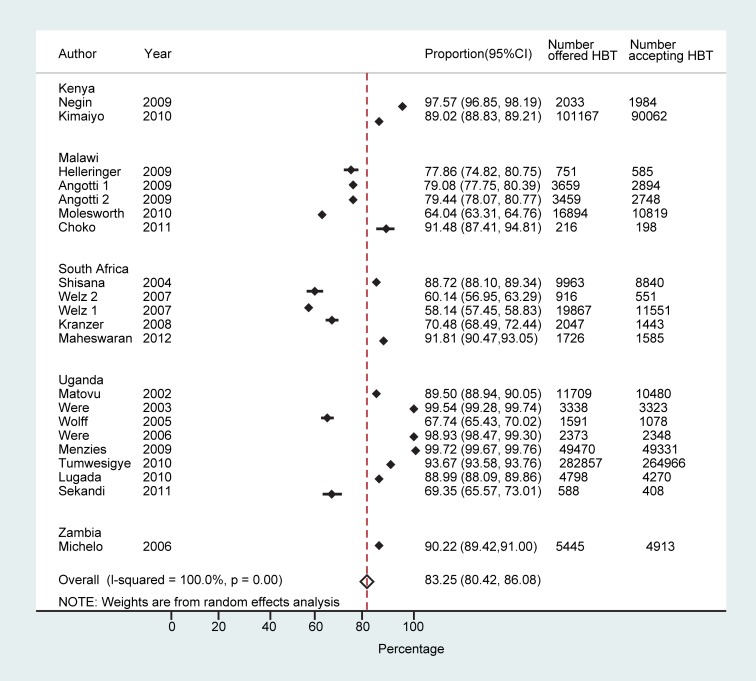
Proportion accepting HBT.